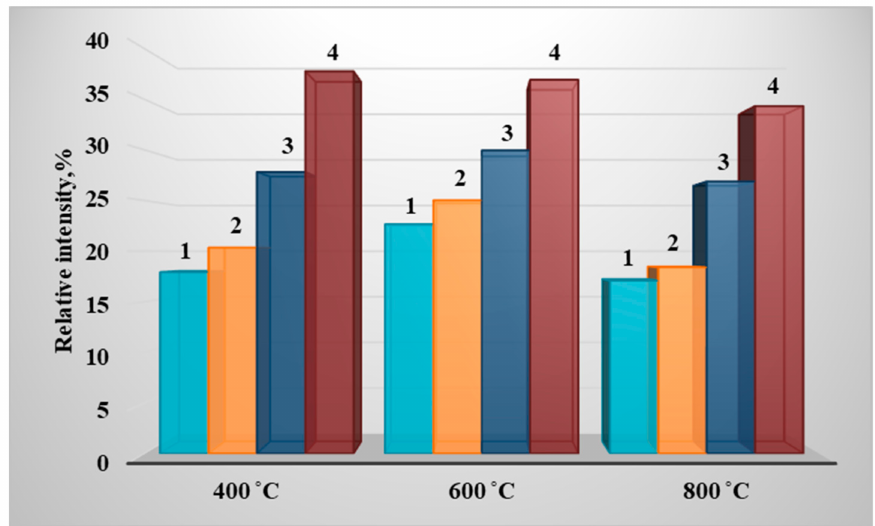
Figure 12. Change in the content of aluminum sulfate in the pyrolysis products of lean coal of grade T, wood and mixtures based on them during the pyrolysis of fuel samples weighing up to 15 g in the absence of oxygen in the temperature range from 400 ◦ C to 800 ◦ C: 1. Coal T_100%; 2. Coal_90%/Wood_10%; 3. Coal T_75%/Wood_25%; 4. Coal T_50%/Wood_50%